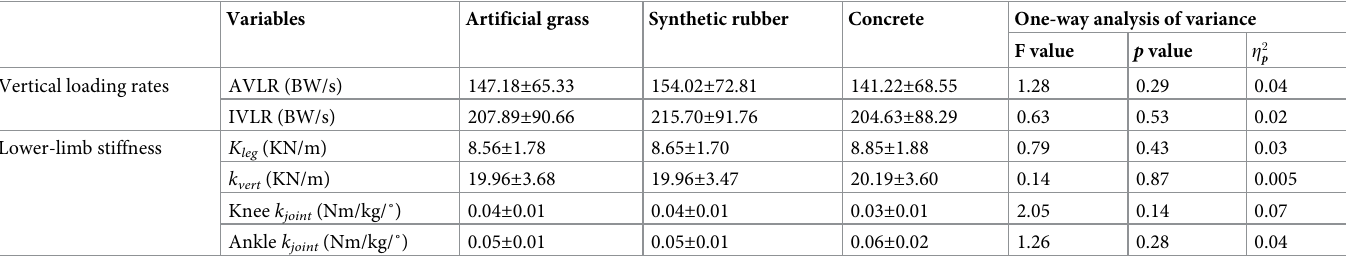
VALR: vertical average loading rate; VILR: vertical instantaneous loading rate; K